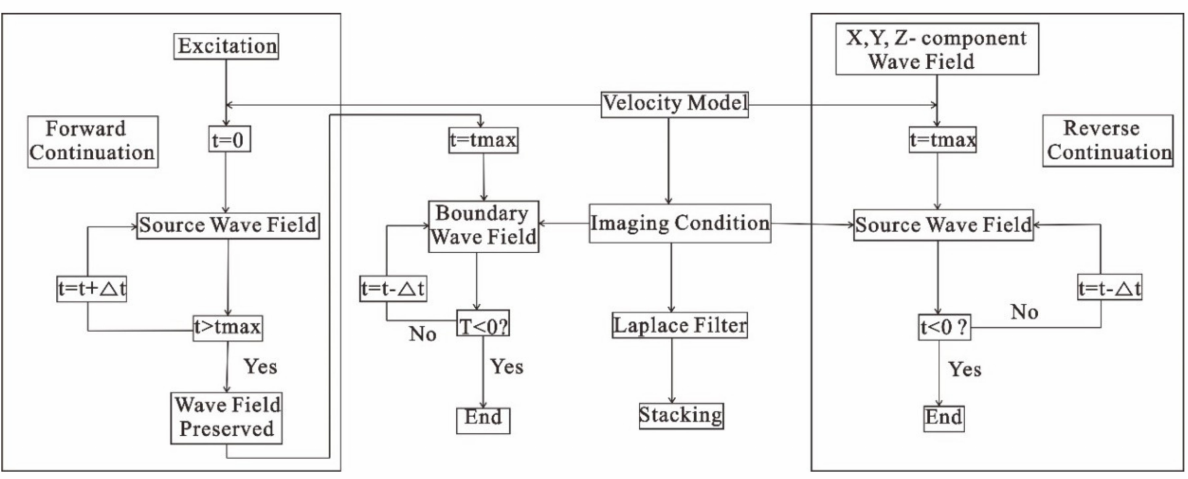
Figure 2. Multi-component RTM imaging calculation flow